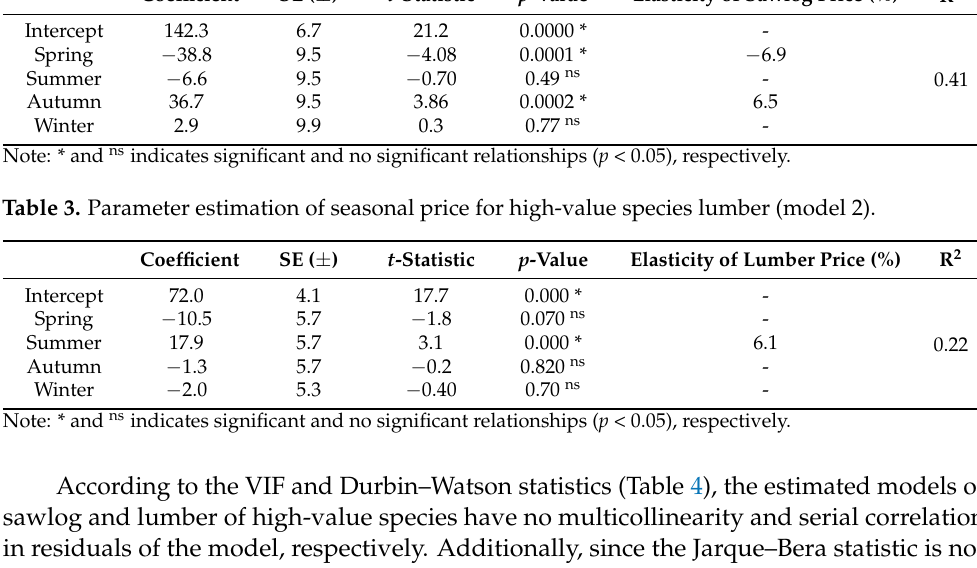
Table 2. Parameter estimation of seasonal price for high-value species sawlog (model 1). Coefficient SE ( ± ) t -Statistic p -Value Elasticity of Sawlog Price (%) R 2 Intercept 142.3 6.7 21.2